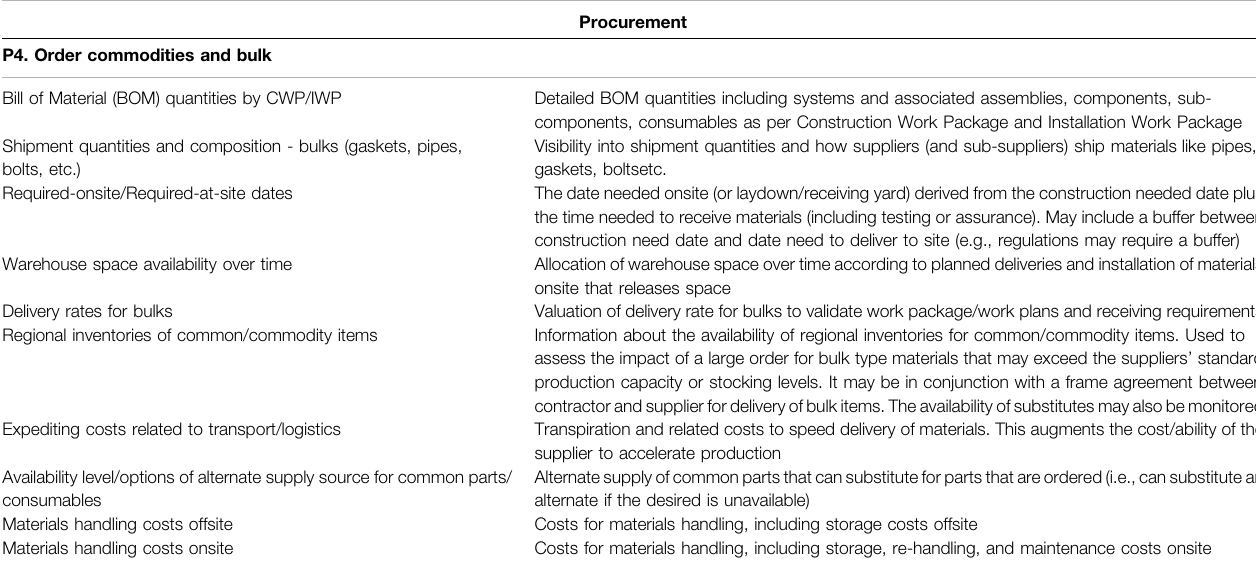
TABLE 5 | Information needed items and de fi nitions for order commodities and bulk of Procurement phase (additional de fi nitions for each phase in the Supplementary Appendix